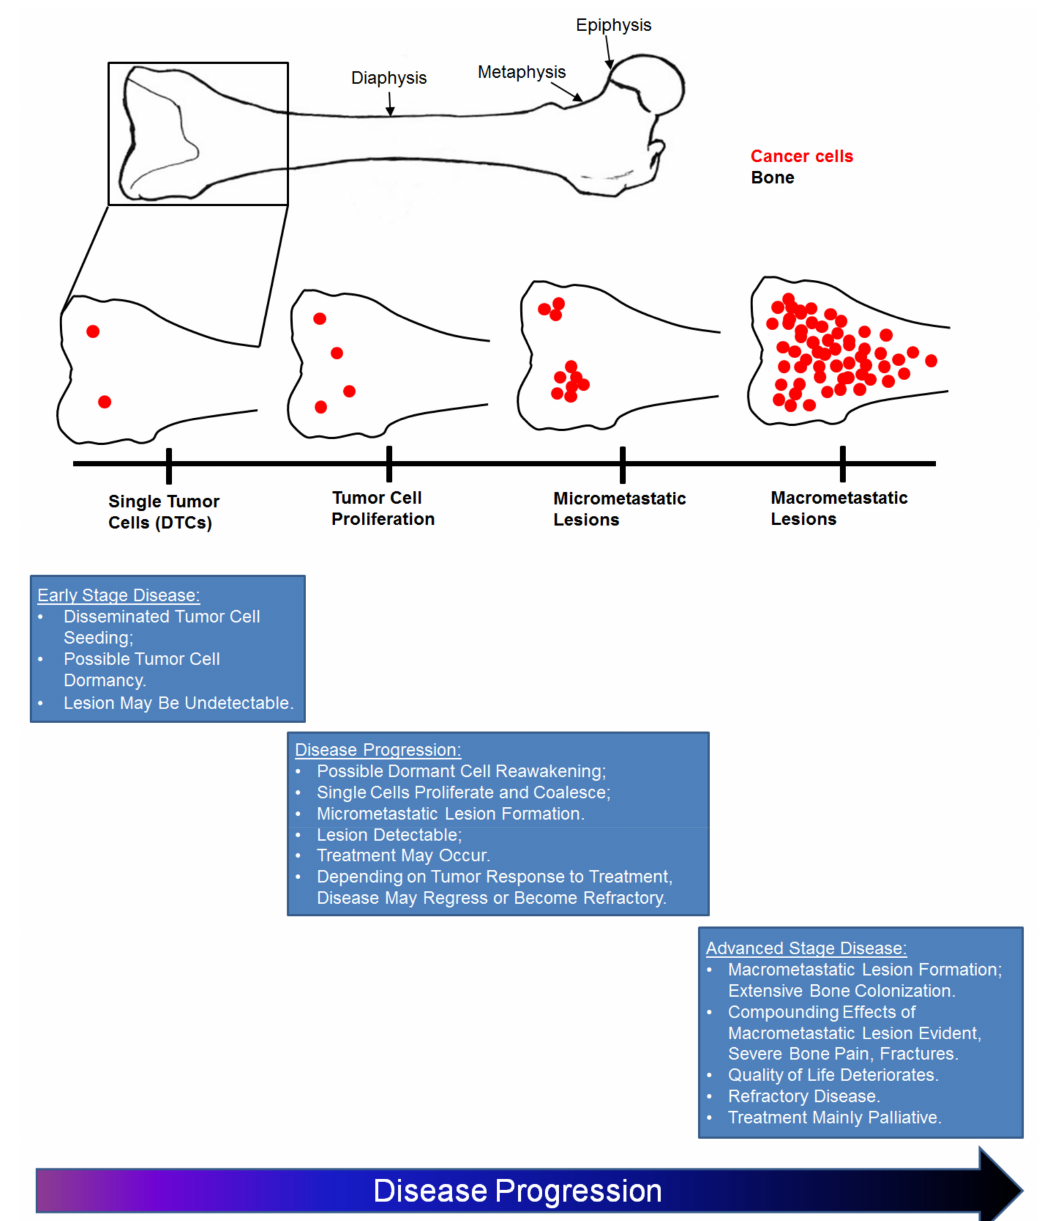
Figure 3. Stages of disease progression during bone metastatic cancer. Bone metastatic cancers may be broadly defined by three overarching stages: early disease, disease progression, and advanced or late stage disease. During early stage disease, disseminated tumor cells circulating in the vasculature enter bone and seed mainly as single cells. Cells may be undetectable by current technological methods due to their solitary nature. Cancer cell dormancy may also occur. As bone metastatic disease progresses over a period of months to years to potentially decades, dormant cancer cells become re-awakened leading to proliferation and coalescing of smaller, micrometastatic lesions. Lesions may become detectable by current technological methods. Treatments to reduce tumor size and alter bone remodeling may occur. Over time, tumors may become refractory to treatment modalities, leading to sustained tumor cell proliferation and excessive tumor burden. Macrometastatic lesions form. Patients may experience effects of increased tumor burden including severe bone pain, fractures, and hypercalcemia. Patient quality of life progressively deteriorates. Treatment modalities during advanced stage disease are mainly palliative to reduce complications from excessive bone tumor